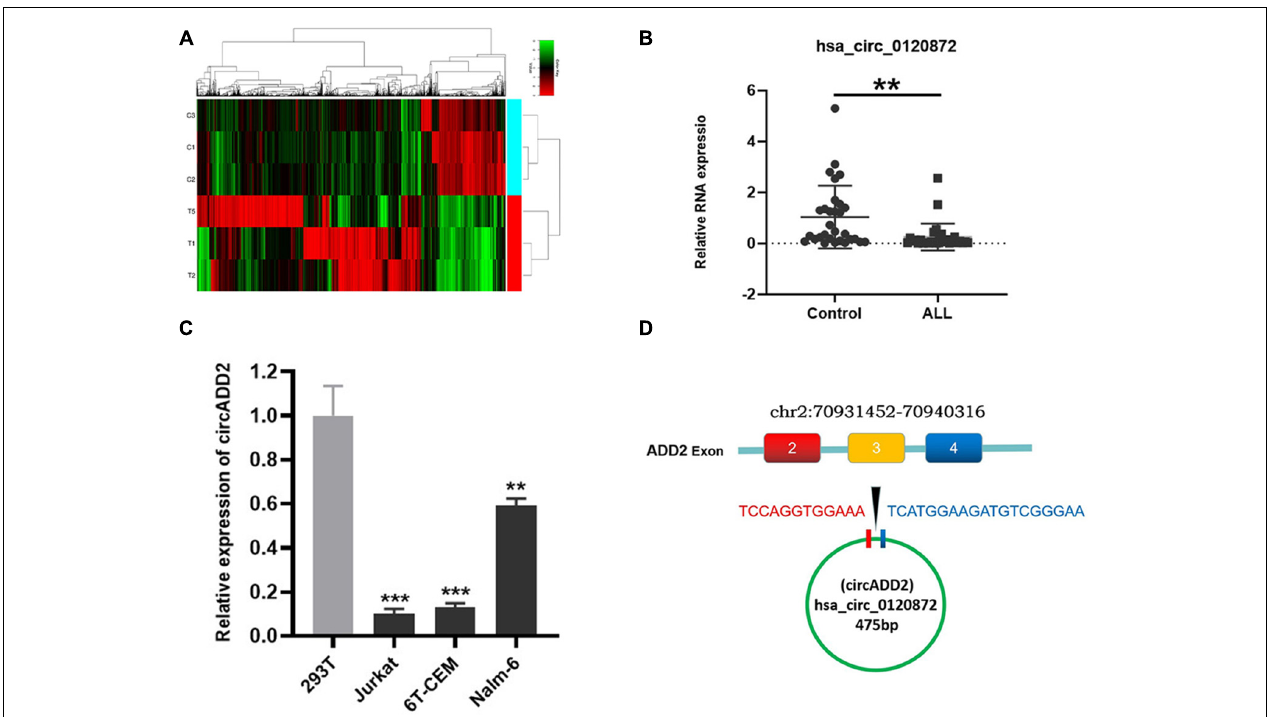
FIGURE 1 | Detection of circRNA expression in childhood ALL. (A) A heatmap showing the differentially expressed circRNAs in ALL and control groups. The results showed a distinguishable circRNA expression profile among samples. Red: upregulation; green: downregulation; black: no change. (B) qRT-PCR confirmed the low expression of circADD2 in children with ALL compared with control group ( n = 30). (C) The circADD2 expression in ALL cell lines was prominently lower than the normal cell line 293T. (D) Genomic loci of ADD2 and circADD2. Data were showed as mean ± SD and analyzed by unpaired t -test, ** P < 0.01, *** P <